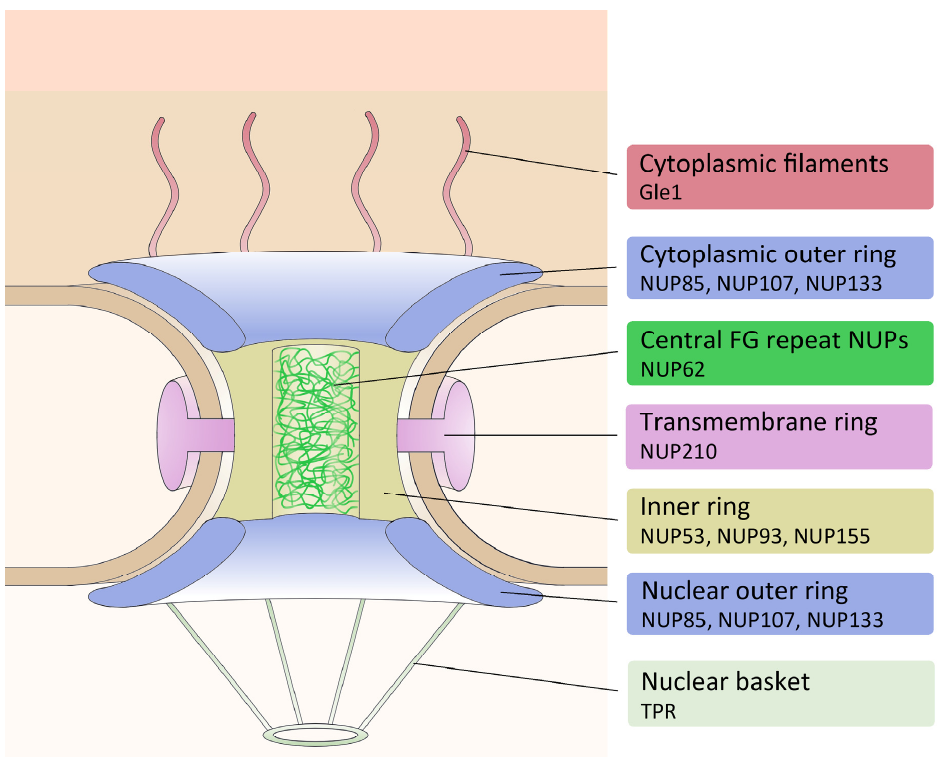
Figure 1. Schematic drawing of the nuclear pore complex. The NPC is organized in several different subcomplexes. The pore consists of an inner ring and two outer rings and is anchored with the membrane via transmembrane nucleoporins. FG-repeat NUPs form a plug inside of the pore to regulate cargo traffic. The nuclear basket projects into the nucleoplasm and eight filaments extend into the cytoplasm. On the right the selected Dictyostelium NUPs are